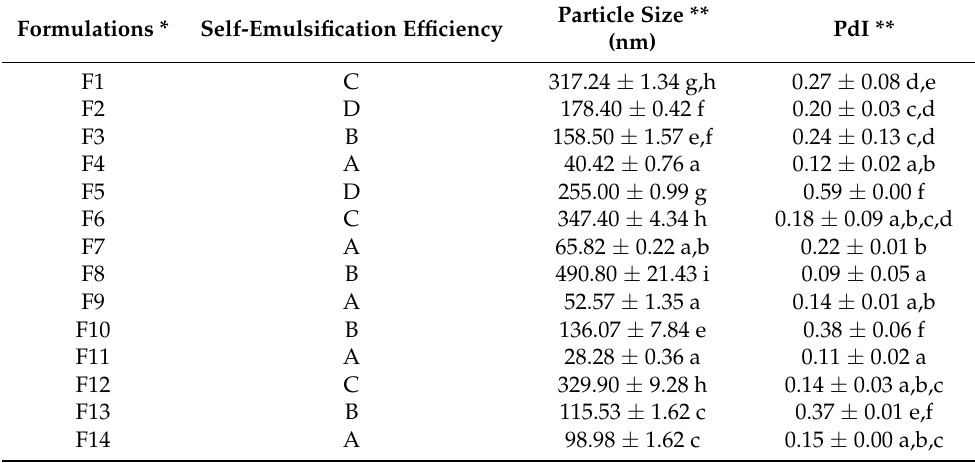
Table 3. The effects of different concentrations of excipients in SNEDDS formulations on self- emulsification efficiency, particle size, and size distribution (PdI) of the obtained nanoemulsions.